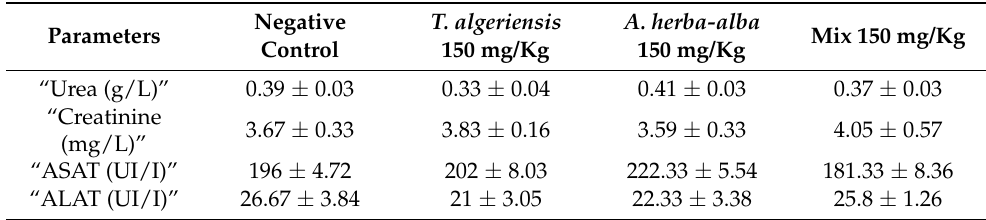
Table 5. Values of biochemical parameters of control and treated mice after 14 days after the single administration of essential oils of T. algeriensis , A. herba-alba , and the mixture at a dose of 150 mg/kg.